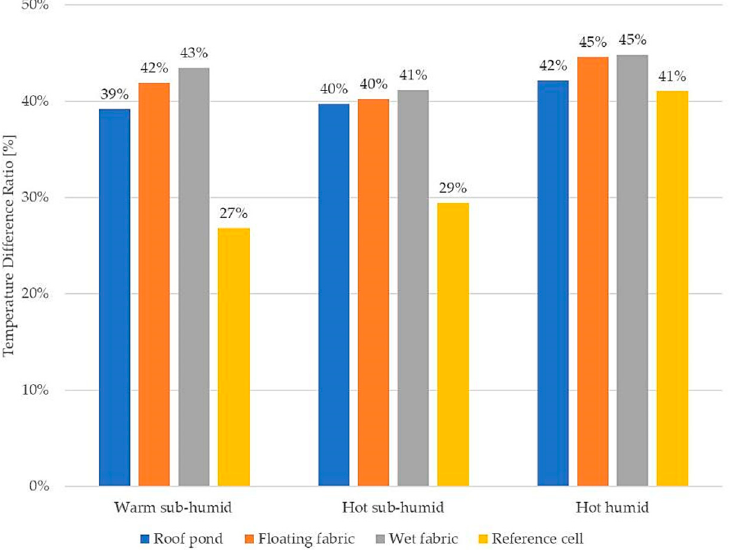
Figure 17. Temperature differences ratio of devices in the three climatic conditions.